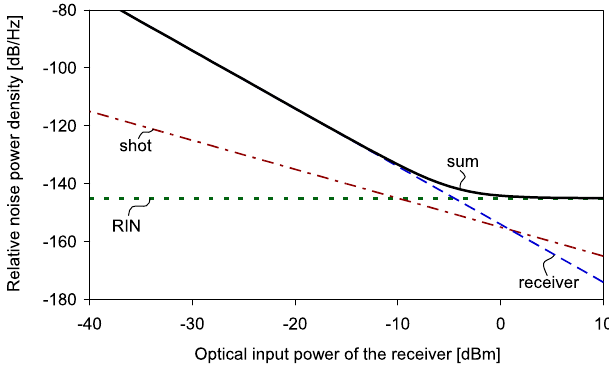
FIG. 10. (Color) Noise in all channels. RIN dominates above (cid:1) 5 dBm of optical input power compared to the shot and receiver